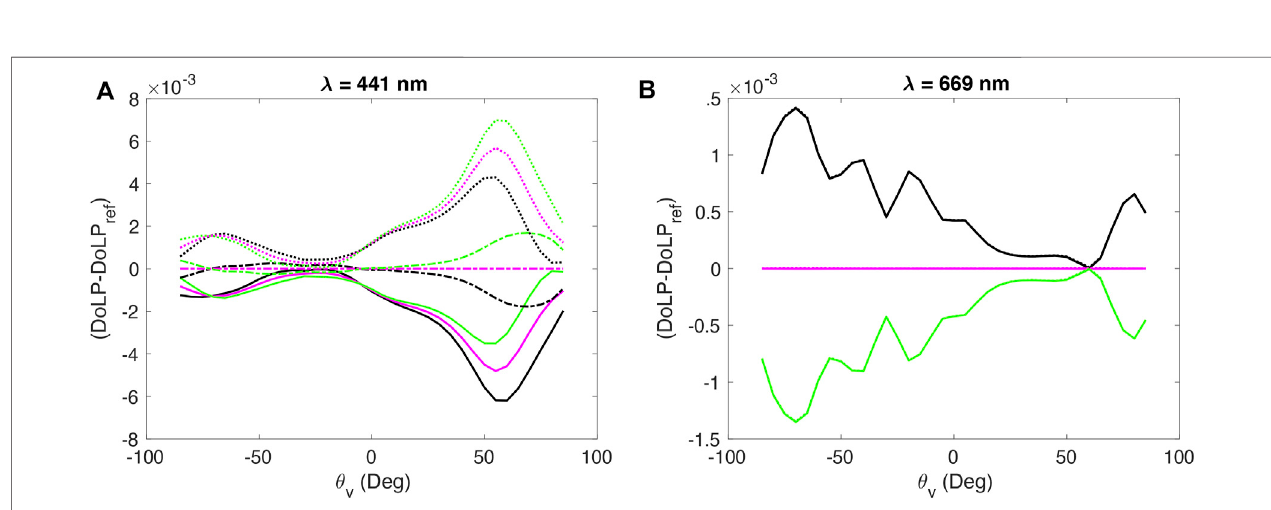
FIGURE 6 | (A) DoLP-DoLP ref in the principal plane as a function of viewing zenith angle at 441 nm, where ref is corresponds to the case of a CDOM ( 440 ) (cid:2) 0 . 0316 m − 1 and the brown carbon aerosol fraction of 0.04 (B) the same as (A) except for the wavelength of 669 nm. The fi gure legend is the same as Figure 5 .